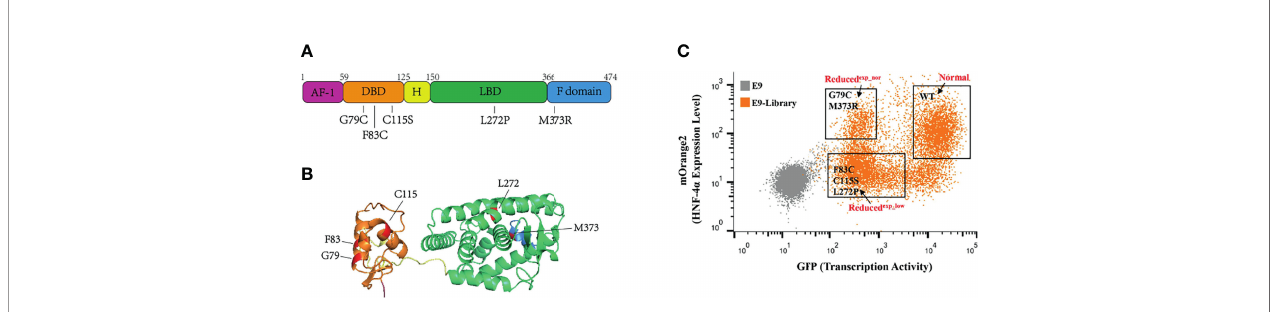
FIGURE 3 | Application of this assay in a small library containing wild-type HNF-4 a and fi ve mutants. (A) Schematic representation of the HNF-4 a (NM_000457.6) structure, and distribution of single amino acid mutations used in this study. Five main functional domains: AF-1, activation function 1 (amino acids 1 – 59), purple color; DBD, DNA-binding domain (amino acids 60 – 125), orange color; H, hinge domain (amino acids 126 – 150), yellow color; LBD, ligand-binding domain (amino acids 151 – 366), green color; F domain (amino acids 367 – 474), blue color. (B) Three-dimensional model of human HNF-4 a (4iqr) with schematic function domains of HNF-4 a and distribution of fi ve deleterious mutations used in this study. The mutations were highlighted in red. Four functional domains: the DBD, orange color; H domain, yellow color; LBD, green color and F domain, blue color. (C) Gating of the HEK293T_pHNF1AP_E9(E9) cells infected with library into three distinct populations based on the GFP and mOrange2 level. The mutants labeled in the gates were identi fi ed through cloning and Sanger